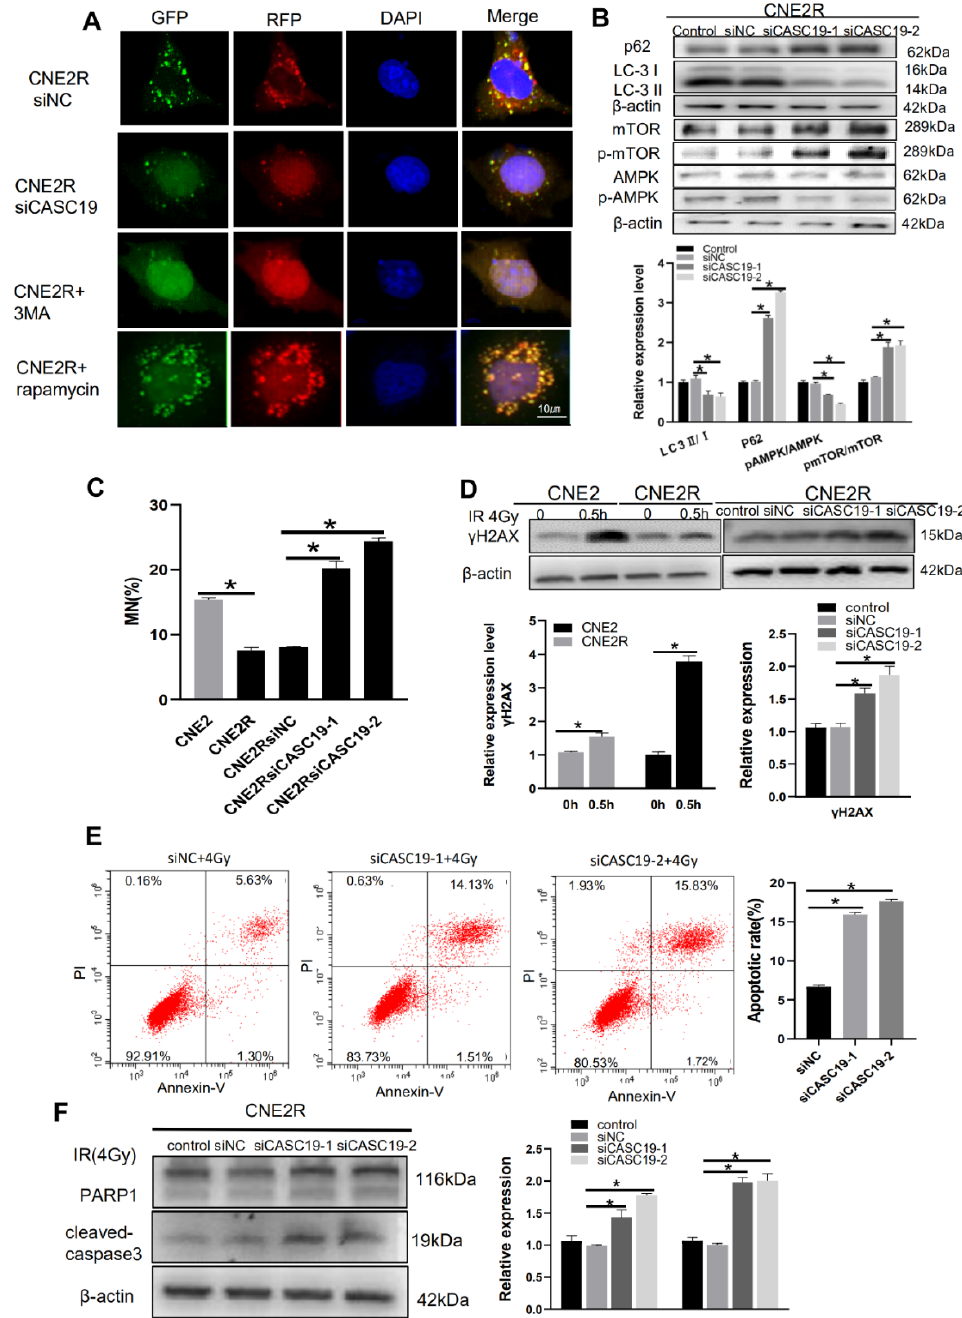
Figure 6. CASC19 knockdown by siRNA inhibited autophagy incidence via the AMPK/mTOR pathway and increased apoptosis in CNE2R cells. ( A ) Fluorescence images of CNE2R cells transfected with siCASC19 and mRFP-GFP-LC3-tagged adenovirus ( × 40). 3-MA was applied as a negative control for autophagy inhibitor and rapamycin was used as a positive control for autophagy induction. ( B ) Western blot assay of P62, LC3, p-mTOR, mTOR, p-AMPK, and AMPK proteins and their relative expression levels in CNE2R cells after transfection with siCASC19-1 and siCASC19-2. ( C ) Micronucleus formation in CNE2, CNE2R, and relevant siCASC19-transfected cells after 4 Gy irradiation. ( D ) Western blot assay of γH2AX protein in CNE2, CNE2R cells, and siCASC19-transfected CNE2R cells at 0.5 h after 4 Gy irradiation. ( E ) Flow cytometry assay of apoptosis in 4 Gy-irradiated CNE2R cells that were transfected with siCASC19 and siNC. ( F ) Western blot analysis of PARP1 and cleaved-caspase3 proteins in 4 Gy-irradiated CNE2R cells that were transfected with siCASC19 and siNC, respectively. * p < 0.05 between indicated groups.